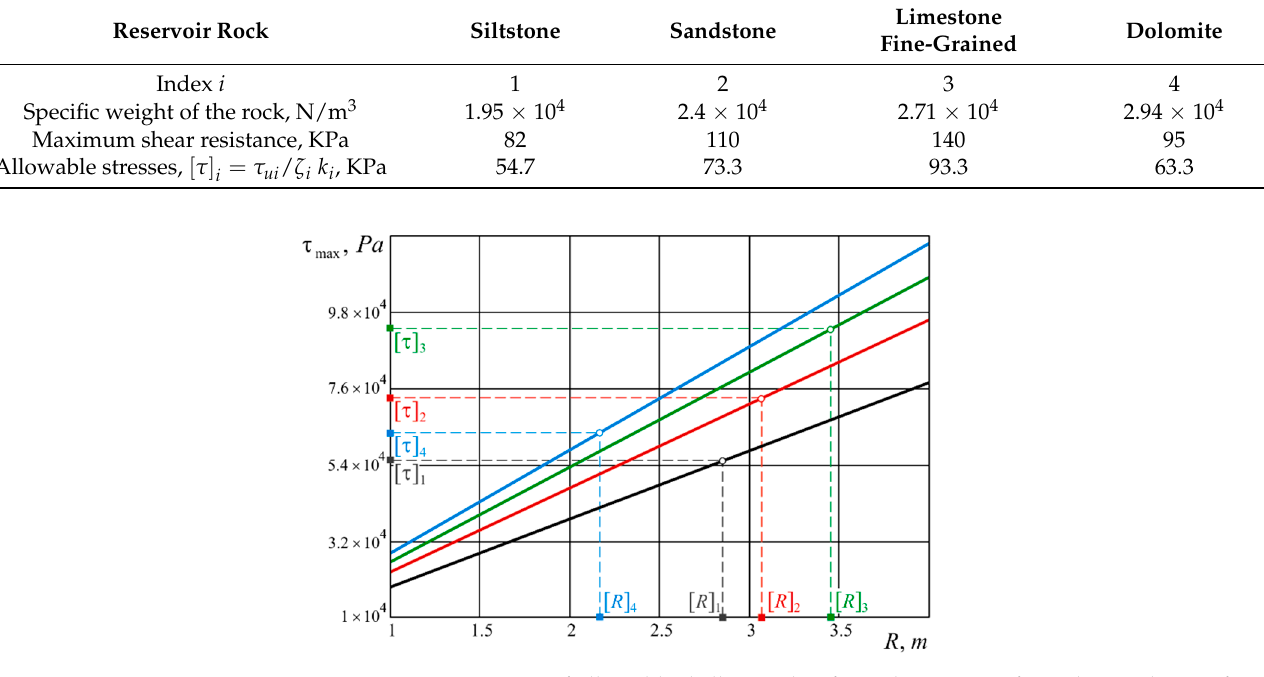
Figure 3. Determination of allowable drilling radii of circular recesses from the condition of rock mass strength: 1—siltstone, 2—sandstone, 3—fine-grained limestone, 4—dolomite.